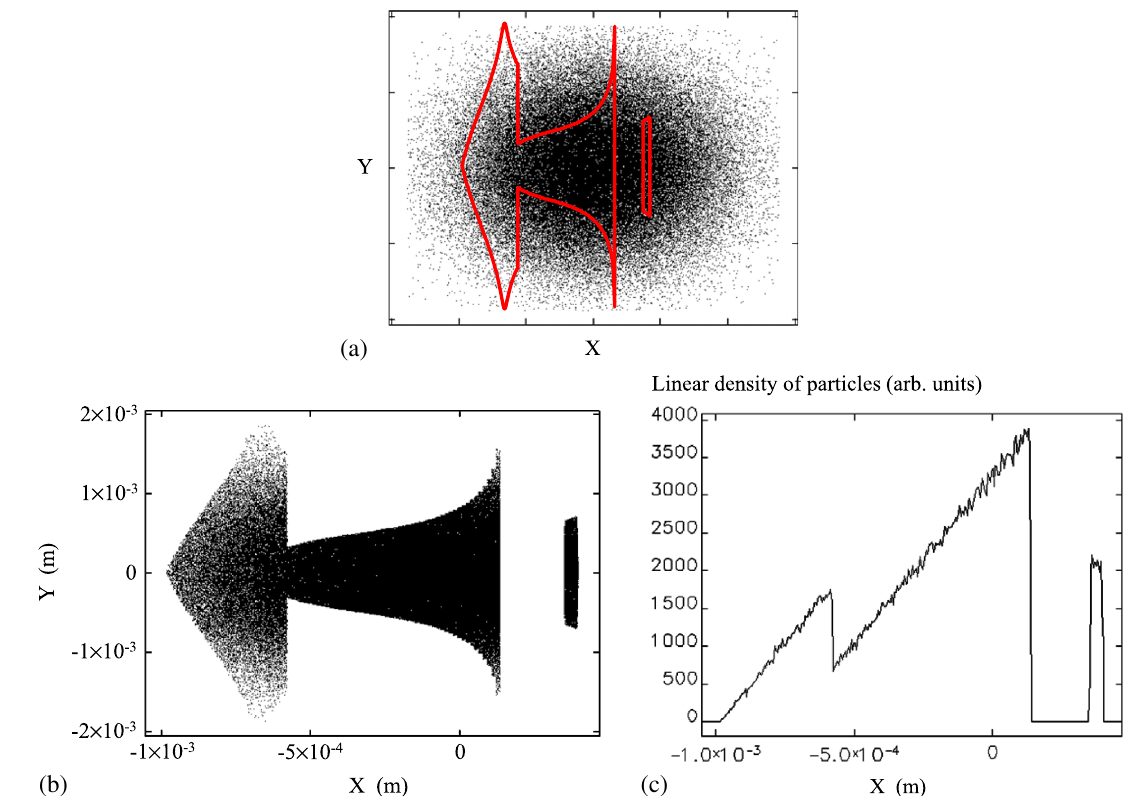
FIG. 2. Illustration of shaping the beam profile with a beam mask at the EEX input to subsequently produce both the drive and the main bunches. The shape of the mask and its orientation with respect to the beam for producing a DT and a trapezoidal x distribution from a Gaussian beam (a). Distribution of particles simulated in Elegant [35] after passing the initial Gaussian beam through the mask (b). Corresponding integral particle distribution along x (c).